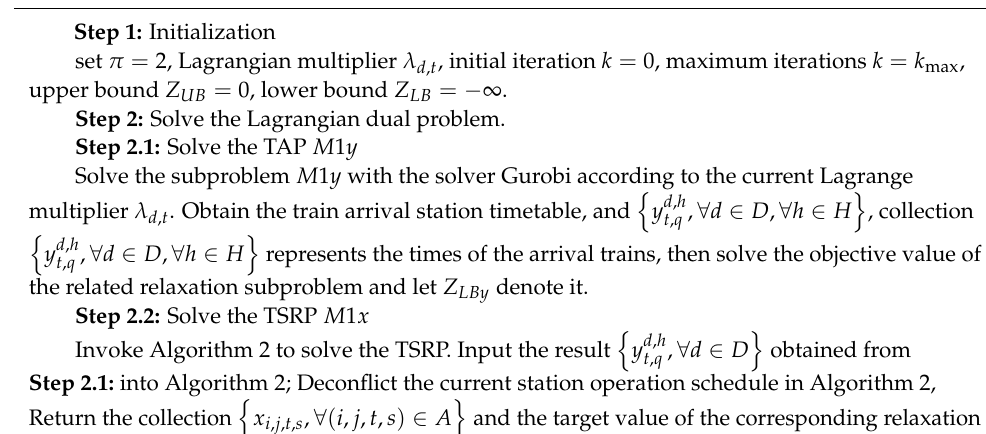
Algorithm 1: Lagrangian